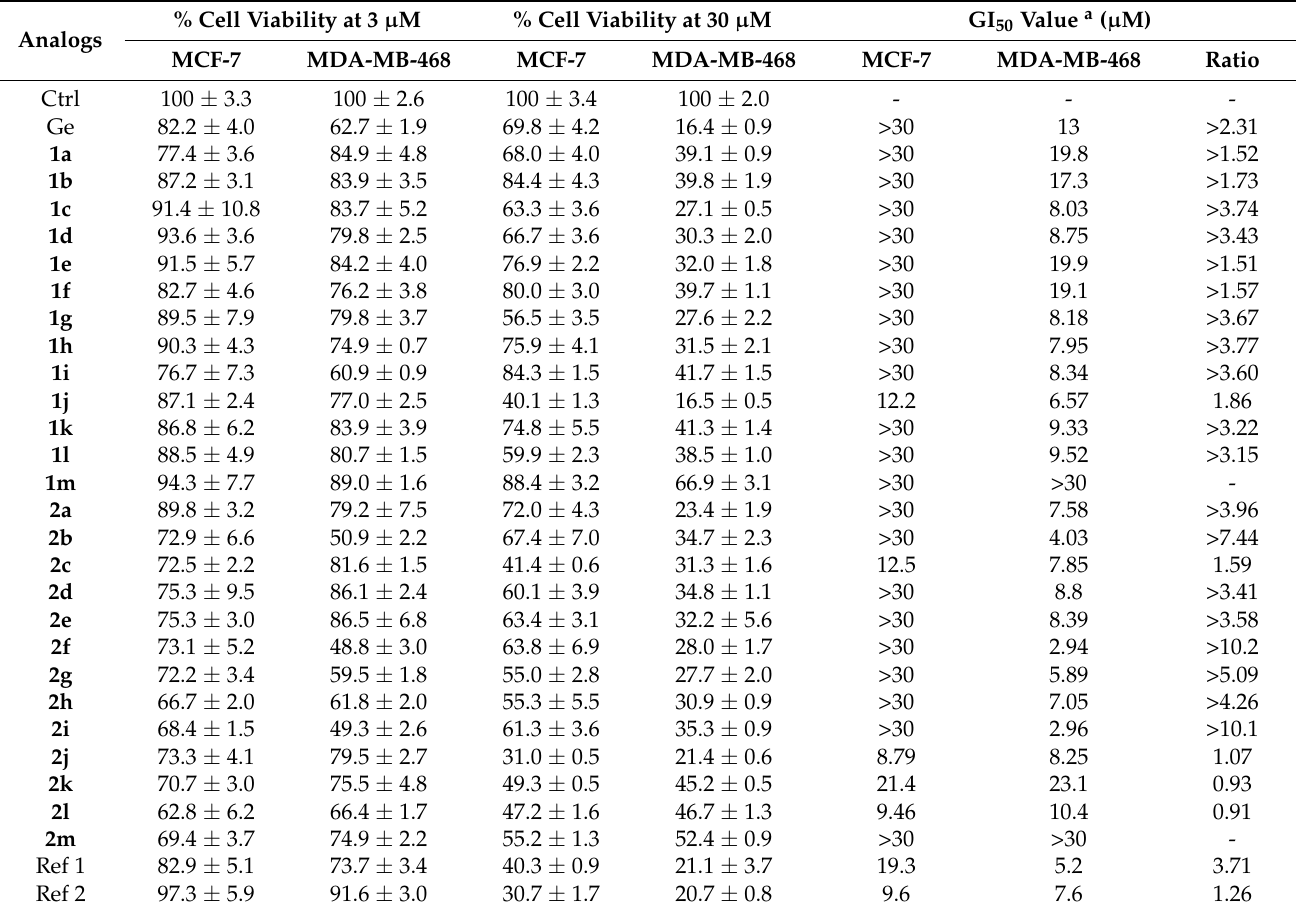
Table 1. Cell viability at 3 and 30 µ M and GI 50 value of 2-(substituted arylmetyl)-1-oxo-1,2,3,4-tetrahydropyrazino[1,2- a ] indole-3-carboxamide analogs (series 1 and 2 ) against the MCF-7 and MDA-MB-468 cell